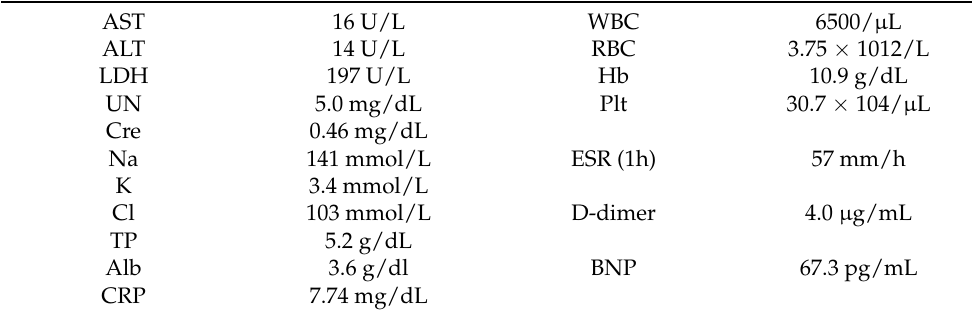
Table 1. Laboratory data on admission.